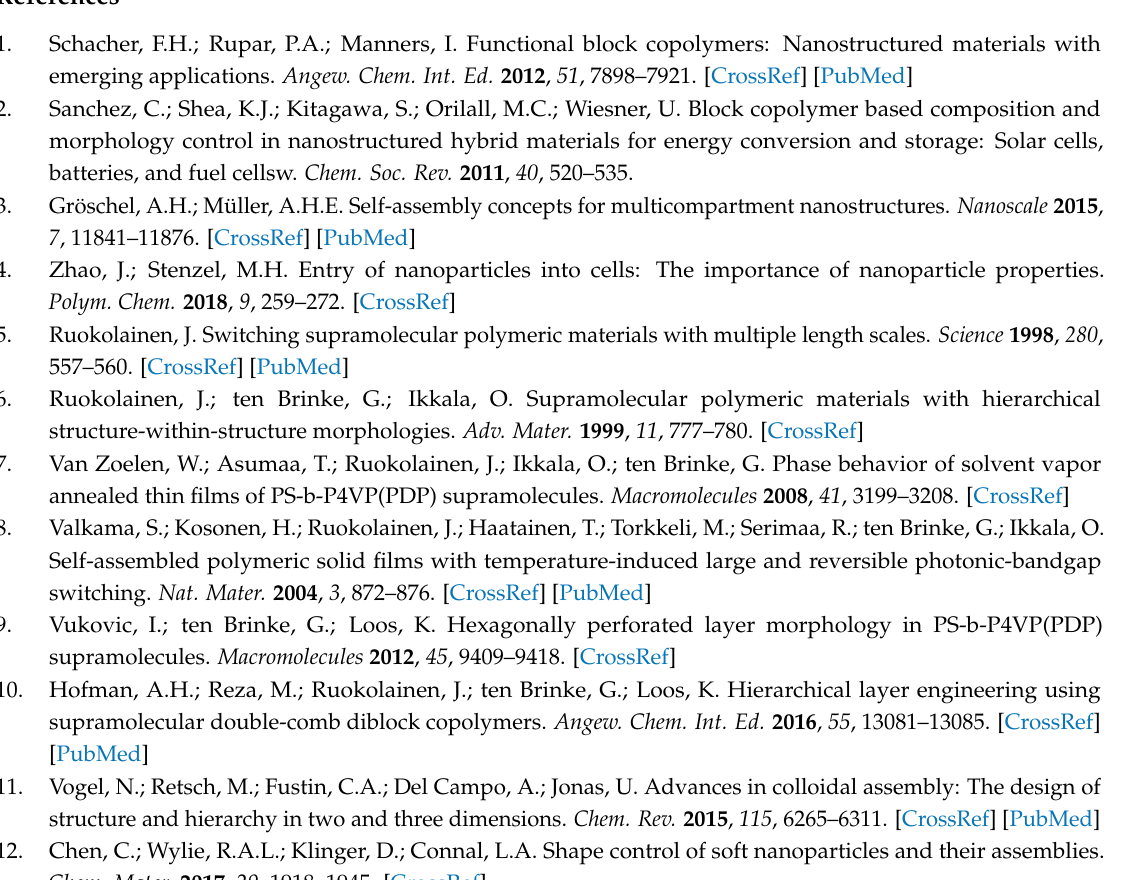
s1, Figure S1: TEM images of SVT2 microparticles after emulsification and evaporation of CHCl 3 . (a) Overview image showing multicompartment microparticles. (b–d) Arrowhead-shaped particles with increasing number of layers. (P4VP was stained with iodine; scale car is 100 nm), Figure S2: Microparticles of SVT1 with varying molar ratios of XB C8 at (a) x = 0.25, (b) x = 0.50, (c) x = 0.75, and (d) x = 1.00 (P4VP was stained with iodine), Figure S3: Infrared spectroscopy (IR) of (a) SVT1 triblock terpolymer before (black) and after complexation with XB A16 (red) and CHEMS (blue) and (b) SVT2 triblock terpolymer before (black) and after complexation with XB A16 (red) and LG (blue), Figure S4: Microparticles of SVT1 with varying molar ratios of CHEMS at (a) x = 0.25, (b) x = 0.50, (c) x = 0.75, and (d) x = 1.00 (P4VP was stained with iodine), Figure S5: Dependence of laser intensity upon concentration for the triblock terpolymers SVT1 and SVT2 solutions in CHCl3 resulting from dynamic light scattering (DLS)